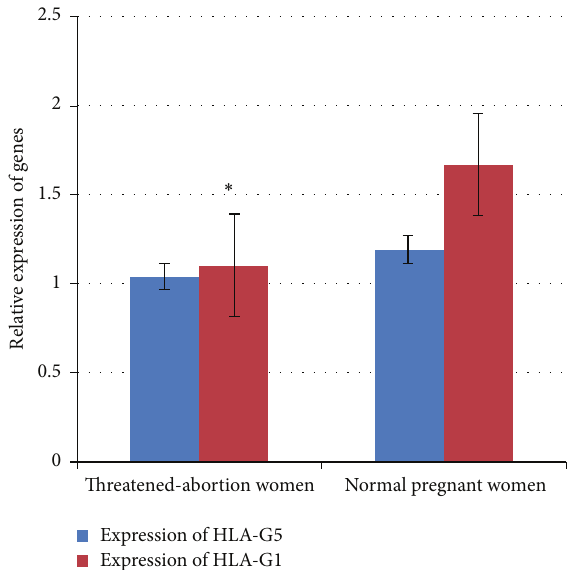
Figure 2: Percentage of NK, NKT, and T cells in the threatened- abortion women as compared to the control group (mean ± SEM). lower compared with the normal pregnant control group ( 3.91 ± 1.46 versus 4.76 ± 2.5 ). But the difference was not significant ( 𝑝 = 0.3 ).